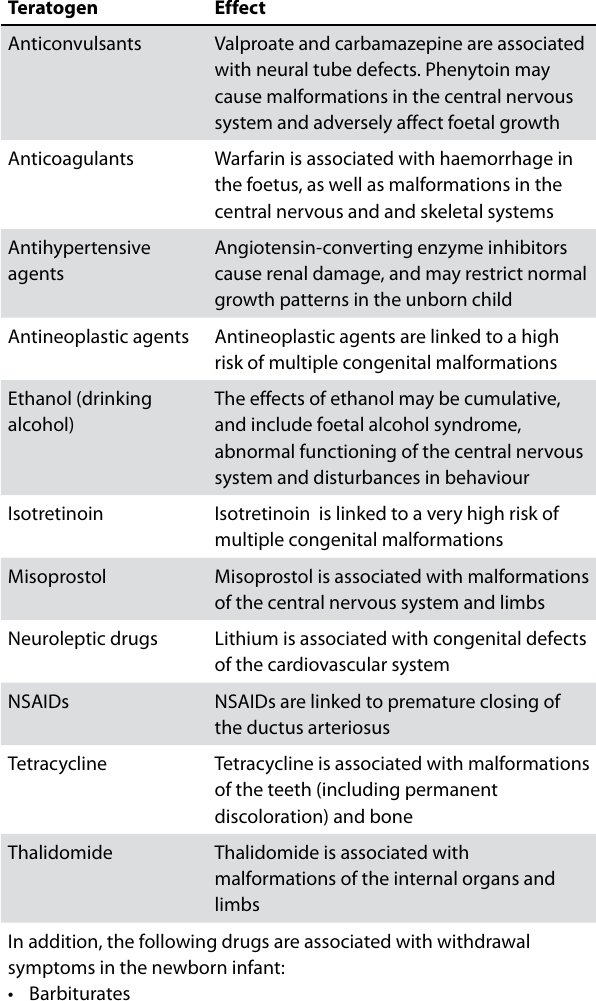
Table 3: Examples of known teratogenic drugs to avoid during pregnancy 1,2,7*